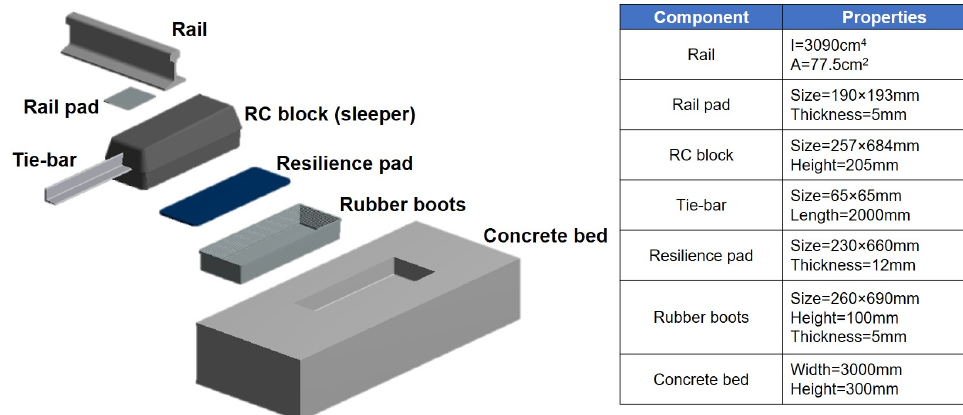
Figure 1. Schematic of the booted sleeper track system (STEDEF).